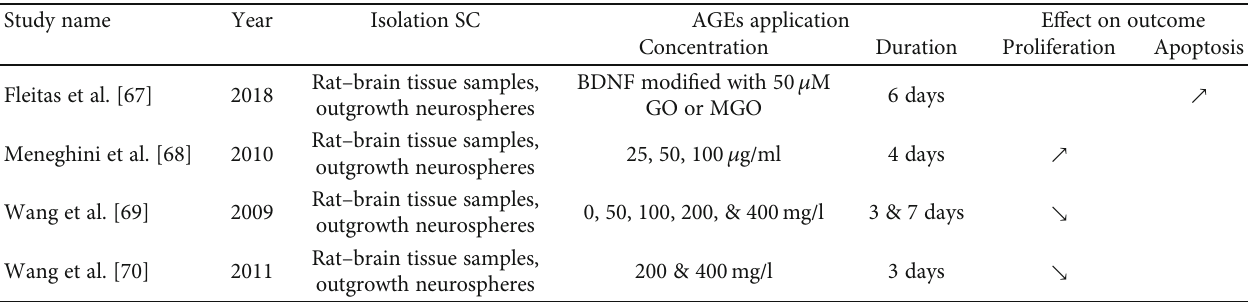
Table 5: Summary of included studies using NSCs. Summary of the isolation procedure and sampling, AGEs concentration, application duration, and e ff ect on outcome measurement proliferation and